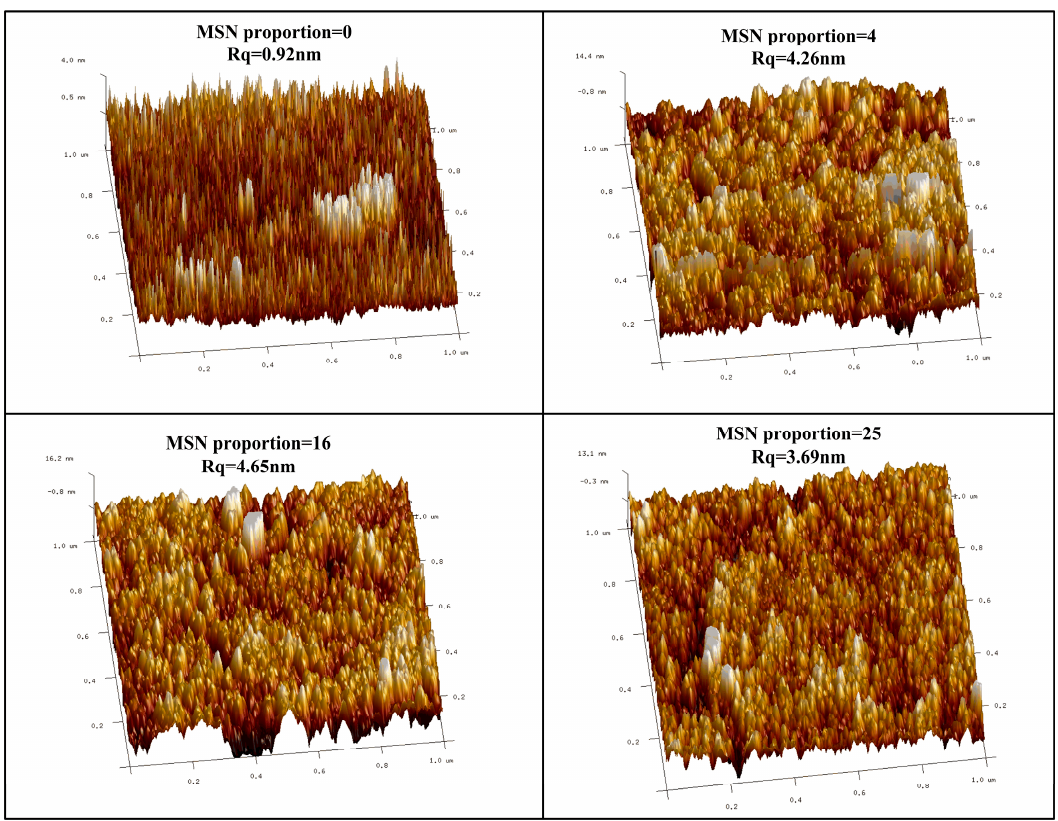
Figure 5. AFM images of polysiloxane coatings with varied MSN embedding